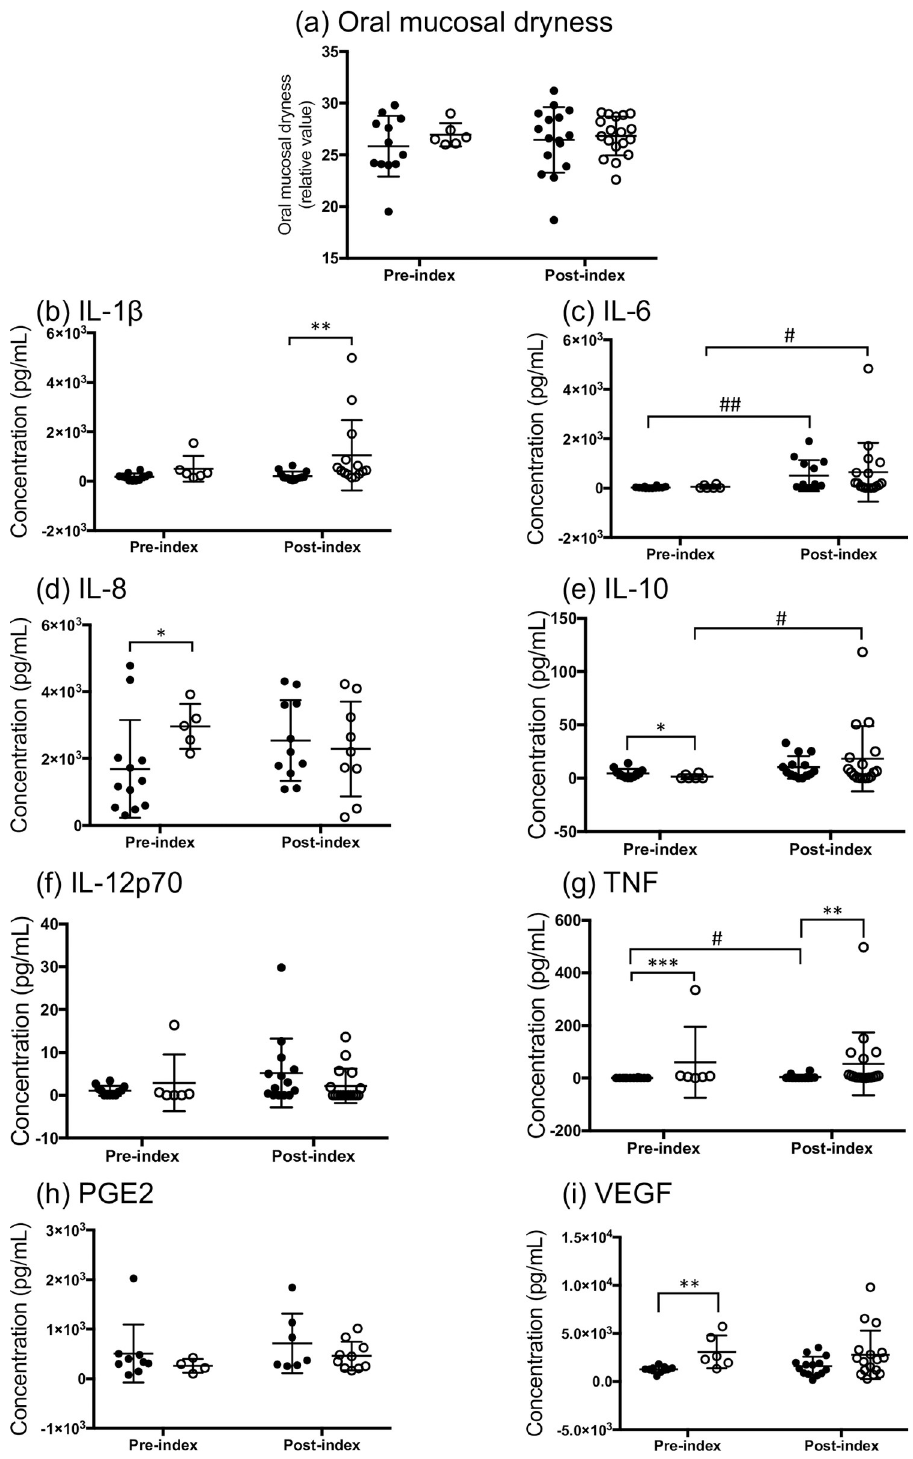
Fig 6. Concentration differences in salivary inflammatory mediators between pre- and post-index patients in each cancer group. (a) Oral mucosal dryness, (b) IL-1 β , (c) IL-6, (d) IL-8, (e) IL-10, (f) IL-12p70, (g) TNF, (h) PGE2, and (i) VEGF. Data are shown as mean ± standard deviation. The closed circles represent patients with leukemia, while the open circles represent patients with head and neck carcinoma. All data for the post-index group were obtained at sampling points 2, 3, and 4, as described in the methods section. The statistical differences between the leukemia